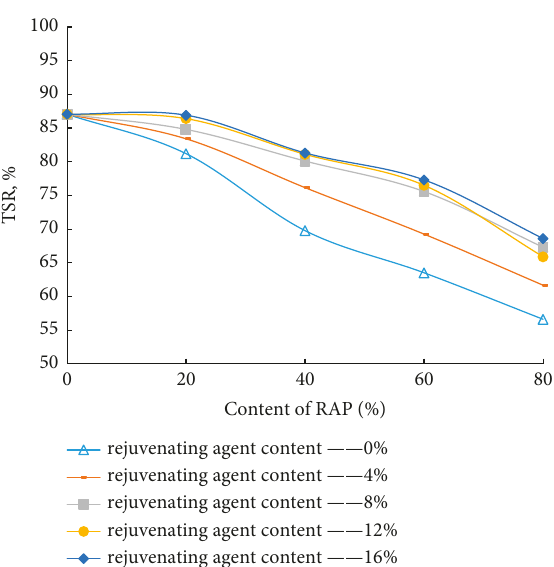
Figure 8: TSR test results with different content of RAP. Figure 10 is the second level determination diagram- matic sketch of the optimal content of regenerant.